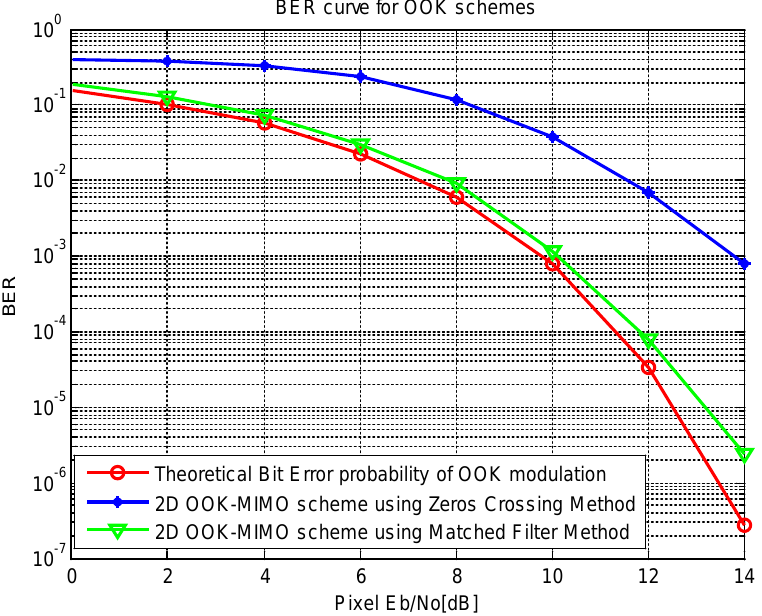
Figure 11. Bit error rate curve for optical OOK modulation schemes.